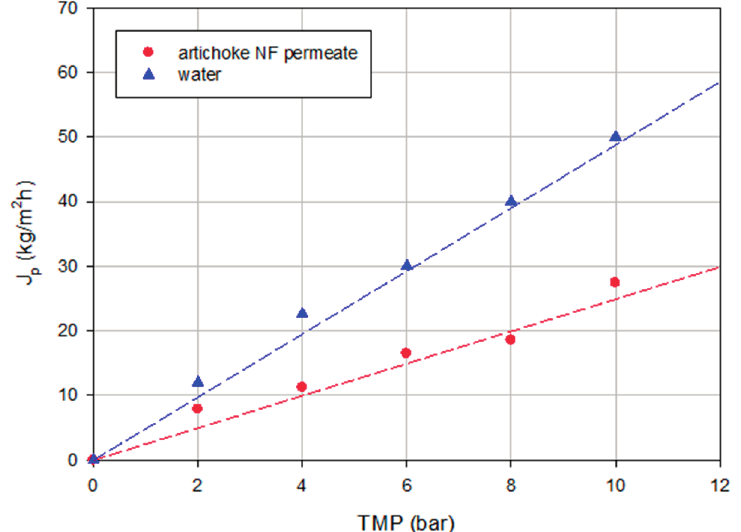
Figure 10. Influence of TMP on the permeate flux of water and the NF permeate of the artichoke extract (Desal DK membrane, total recycle configuration, 25 °C).